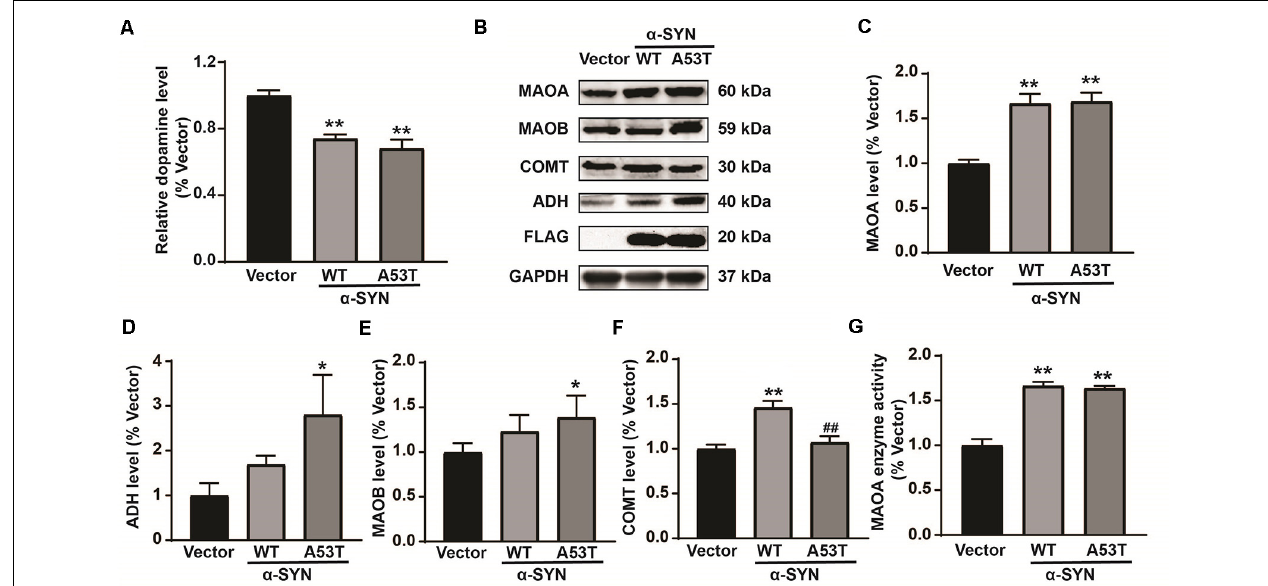
FIGURE 1 | Impacts of α -SYN WT and α -SYN A53T on dopamine (DA) content and DA metabolism-associated enzymes. The DA content was detected in α -Synuclein ( α -SYN) [wild-type (WT), A53T] stably overexpressed and control (Vector) cells with a mouse DA Elisa kit (A) . Western blot detected the protein level of DA metabolism-associated enzymes [Monoamine oxidase A (MAOA), Monoamine oxidase B (MAOB), catechol O-methyltransferase (COMT), and alcohol dehydrogenase (ADH)] (B–F) . MAOA enzyme activity was detected in α -SYN overexpressed cells with a mouse MAOA Elisa kit (G) . Data were expressed as mean ± SEM. ** p < 0.01 vs. Vector transfected cells, * p < 0.05 vs. Vector transfected cells, ## p < 0.01 vs. α -SYN-WT transfected cells, n = 3.